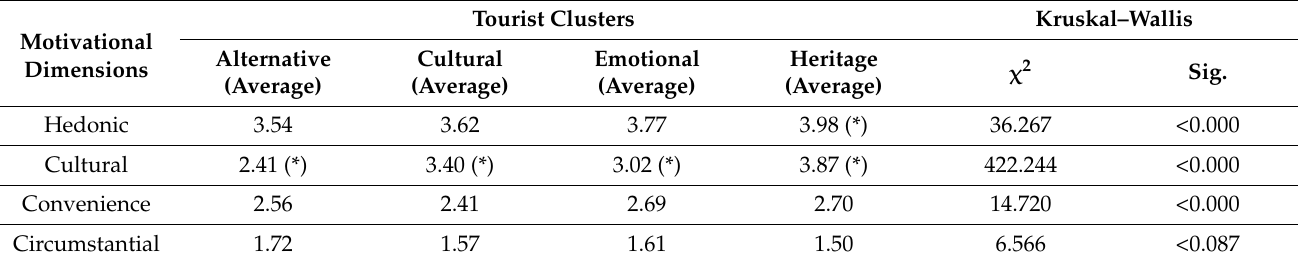
Table 3. Motivation analysis of tourist